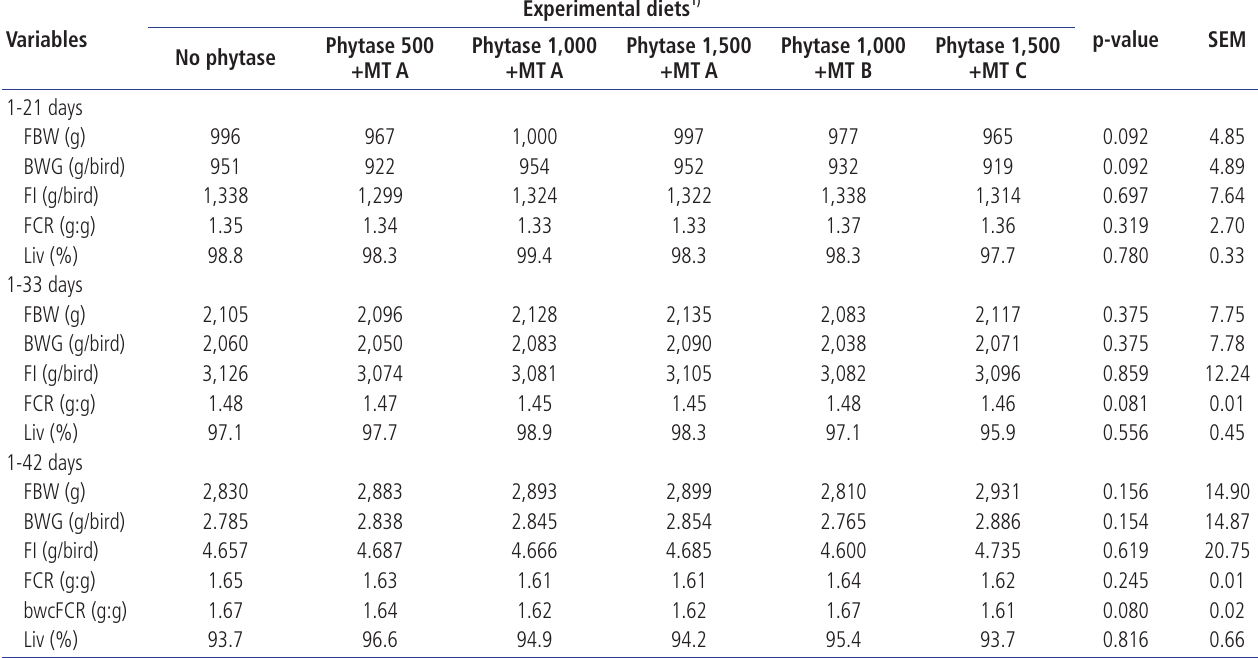
Table 5. Performance of broilers fed diets supplemented with phytase from1to 21, 33, and 42 days of age